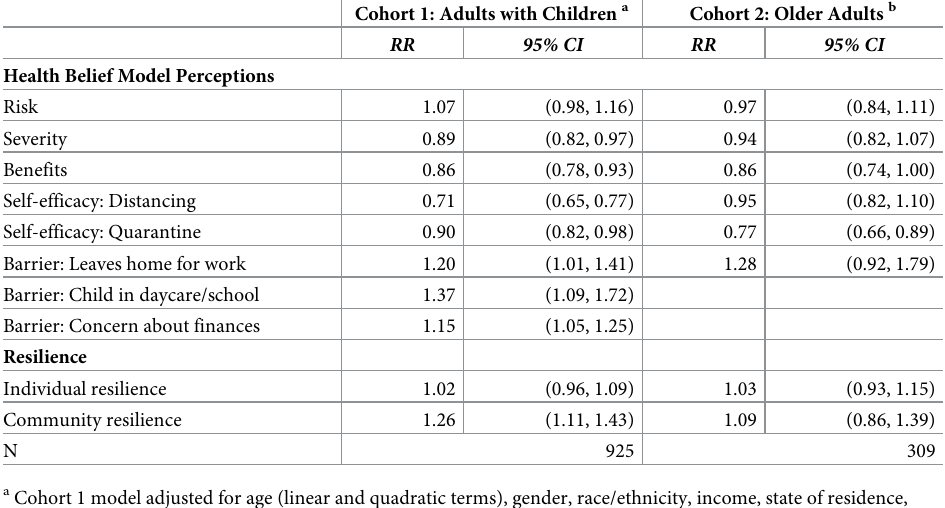
Table 2. Results of negative binomial models testing the effect of Health Belief Model (HBM) and resilience con- structs on non-work, non-household contact rates during April and May 2020. Cohort 1: Adults with Children a Cohort 2: Older Adults b